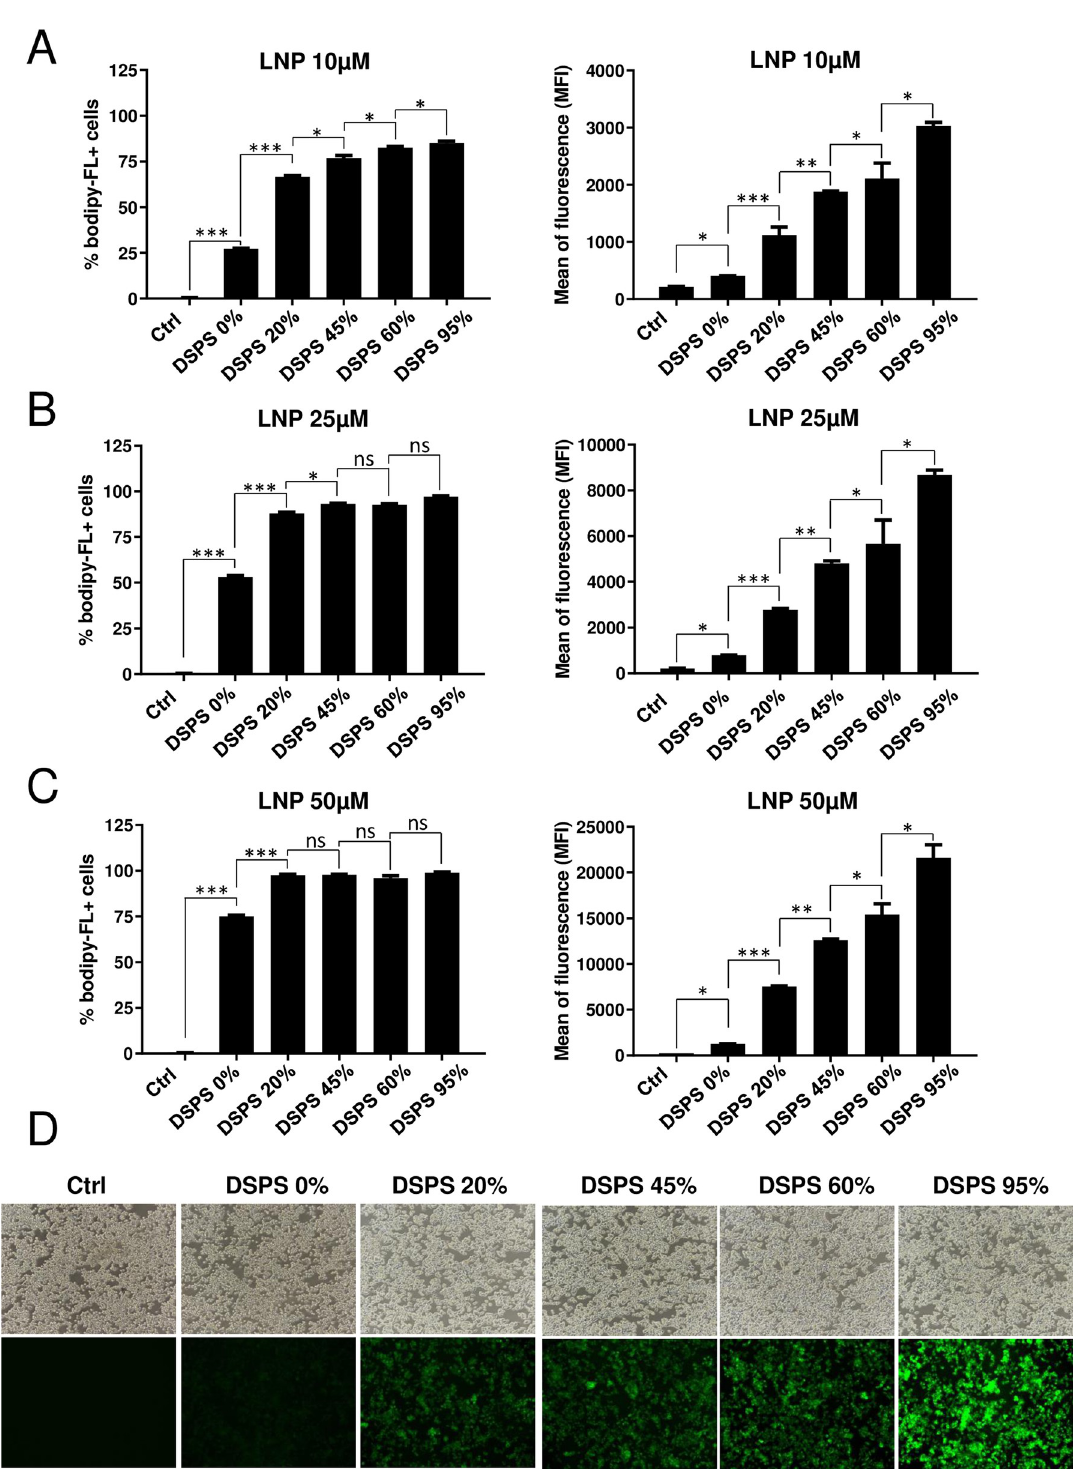
Fig 2. Influence of DSPS on the pickup rate of LNP in macrophage cell line RAW264.7. (A-C) RAW264.7 cells (2 × 10 6 ) were treated/nontreated with LNP containing 0% to 95% of DSPS at (A) 10, (B) 25, (C) 50 μ M, for 24h. The percentage of positive cells (positive for fluorescent probe bodipy-FL) as well as the mean fluorescence intensity were measured by flow cytometry. (D) Images of RAW264.7 cells obtained by epifluorescence microscopy at 24h of treatment with LNP at 10 μ M. The results are representative of two experiments. Data were represented as mean ± standard deviation (SD). Statistical analyses were performed by a One-way ANOVA